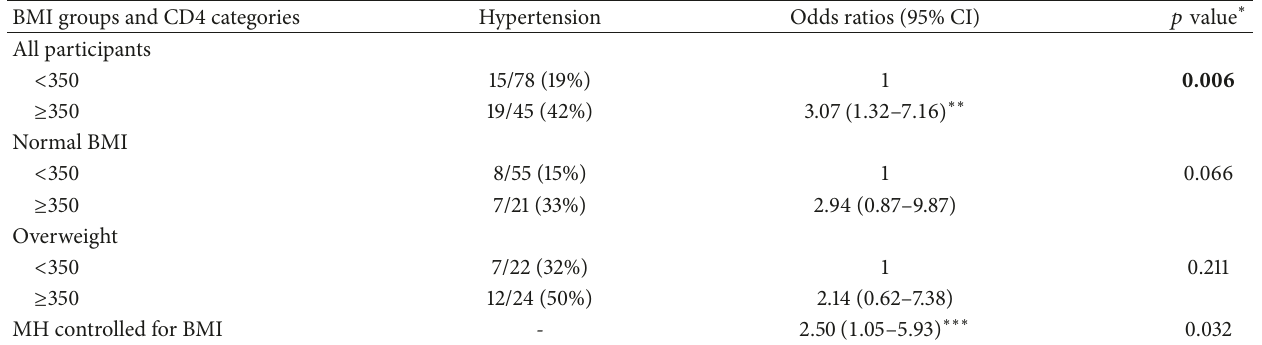
Table 4: Association between CD4 and hypertension across BMI categories, 𝑛 = 123 .